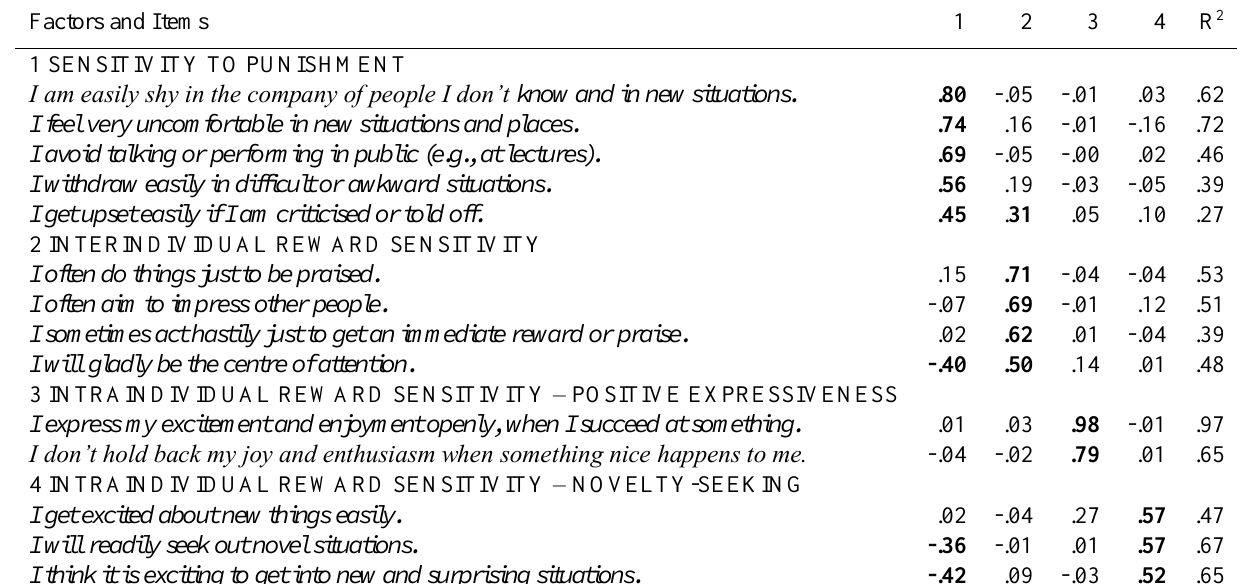
Factor Loadings (ESEM) of Reward and Punishment Sensitivity, and Explained Variance of Items (Study 2). Factors and